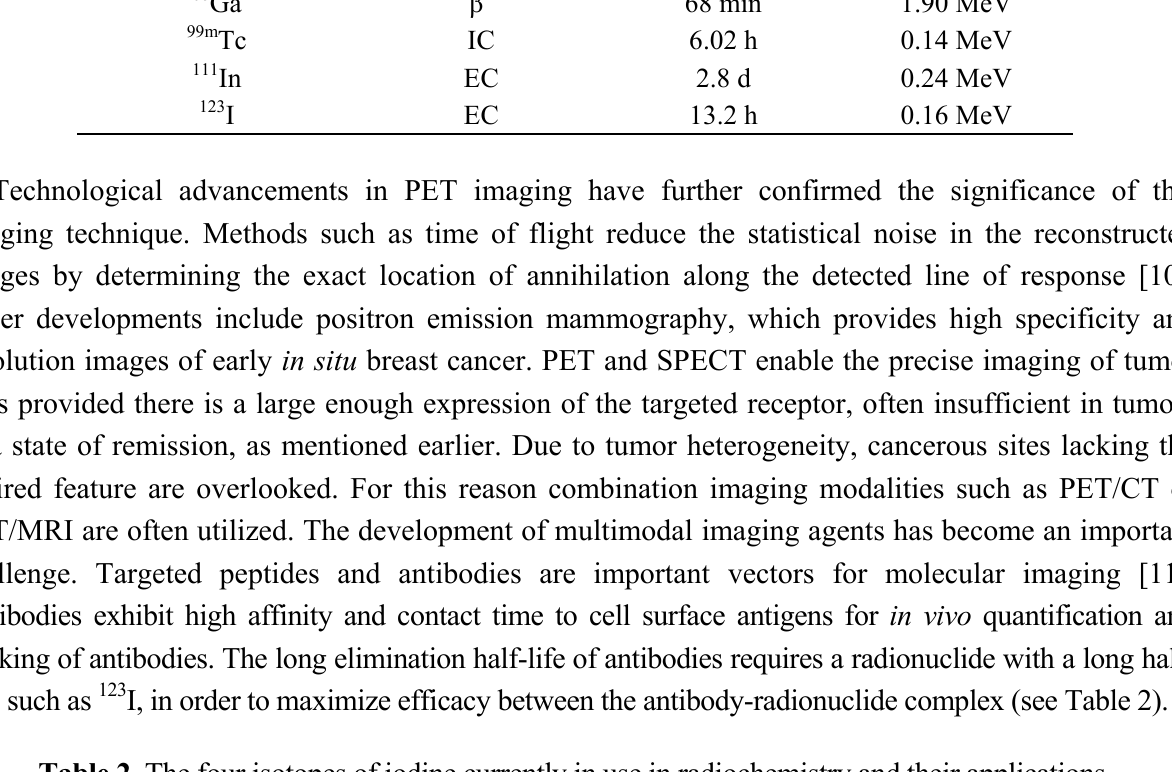
Table 2. The four isotopes of iodine currently in use in radiochemistry and their